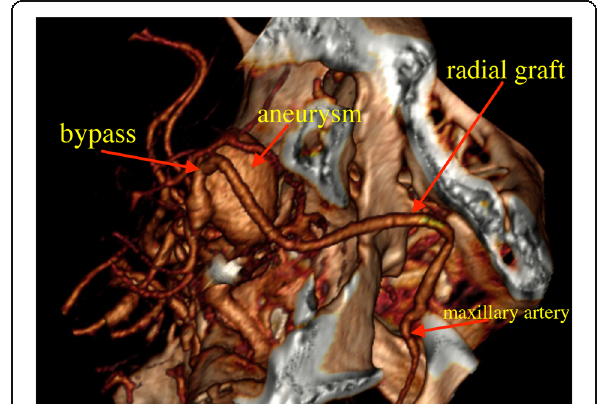
Fig. 3 CT angiography showed a good patency of the